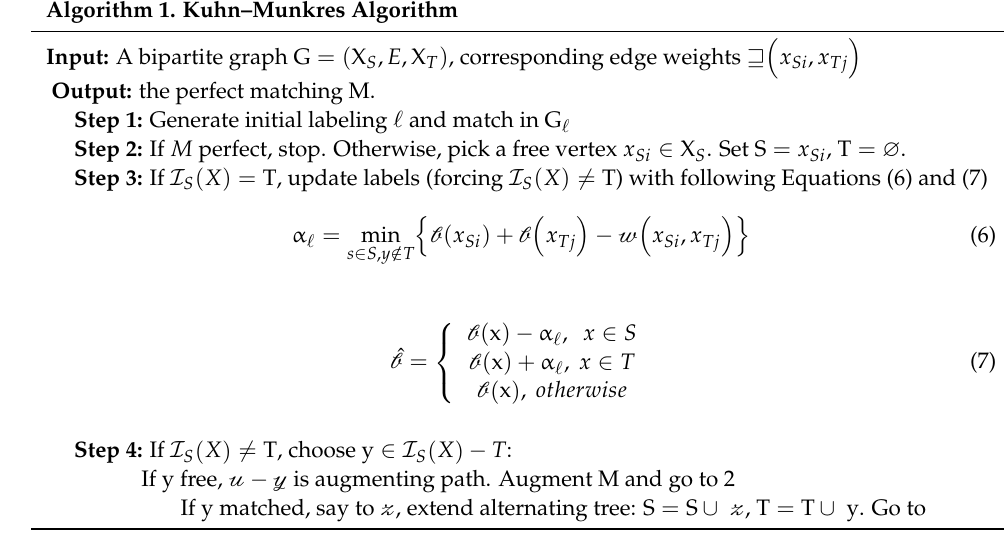
Algorithm 1. Kuhn–Munkres Algorithm